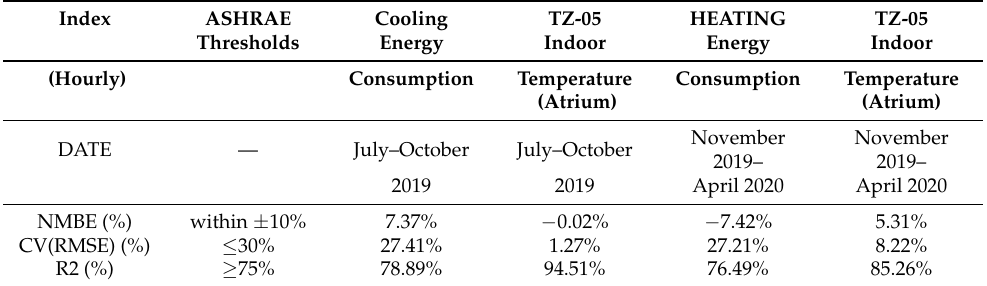
Table A8. Results of HP system calibration for cooling and heating periods,